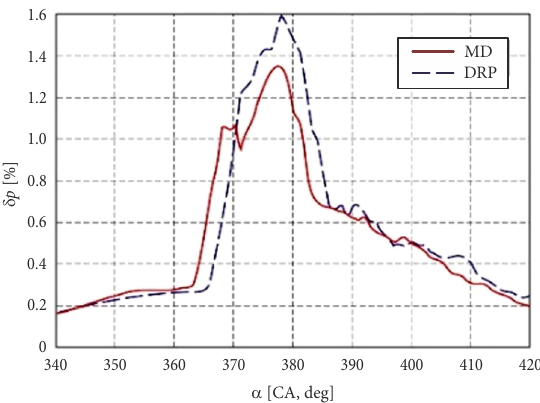
Figure 2. Mean cycle-by-cycle differences in cylinder pressure vs CA for MD and DRP (1500 rpm / 150 N ⋅ m)